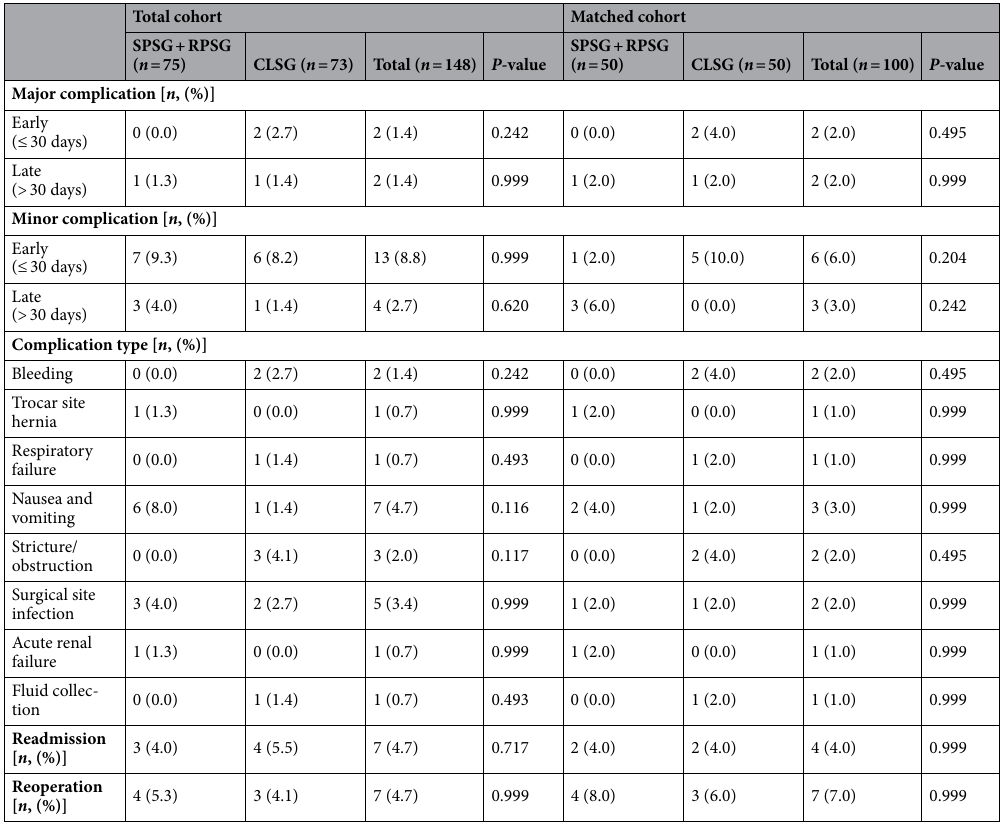
Table 4. Postoperative complications in the total and propensity score-matched cohorts. SPSG single-port sleeve gastrectomy, RPSG reduced port sleeve gastrectomy, CLSG conventional laparoscopic sleeve